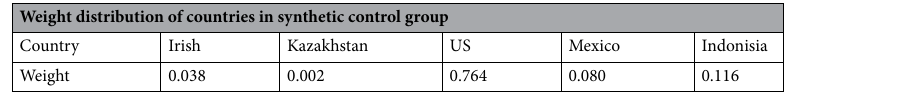
Table 5. Weight distribution of countries in synthetic control group (energy consumption per unit GDP).